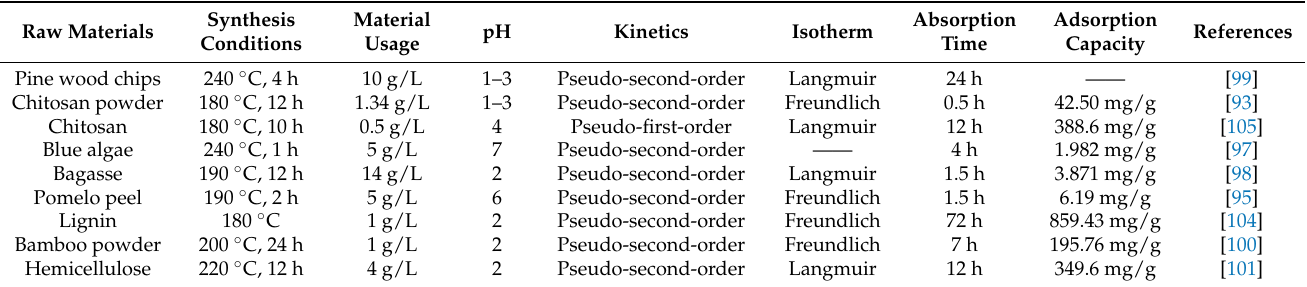
Table 5. Preparation conditions of hydrochar and Cr (VI) in adsorption wastewater.